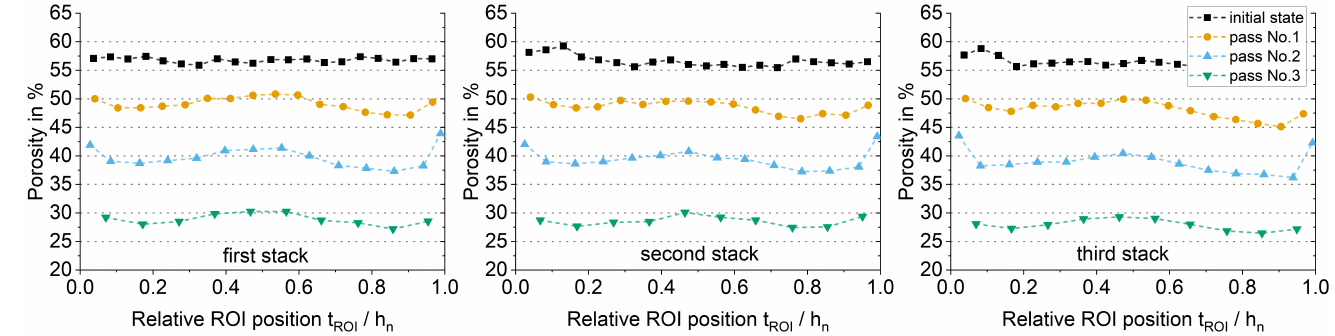
Figure 11. Series I: 20-0.05-10 ( l d / h m ≈ 0.2): Porosity change over relative sample depth (0= upper surface; 0.5= mid-section of sample; 1 =lower surface) due to rolling for first, second and third stack.